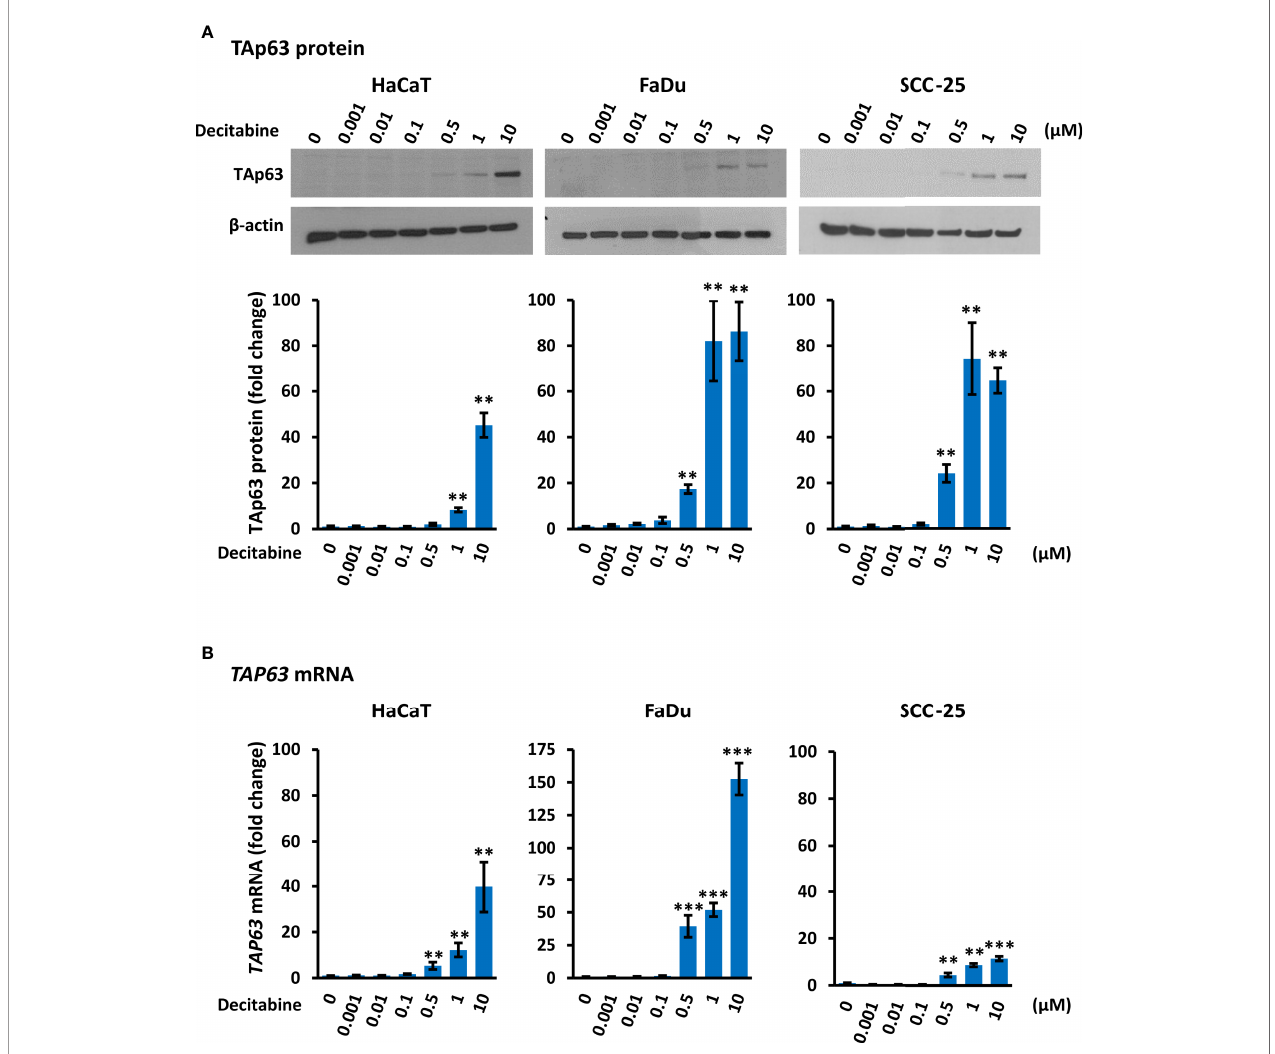
FIGURE 1 | Decitabine increases TAp63 protein and mRNA levels in squamous cells . (A) Representative Western blots of TAp63 in HaCaT, FaDu and SCC-25 cells cultured in the presence of the indicated concentration of decitabine for four days. b -actin is shown as loading control. Densitometry data normalized to b -actin are shown below, indicating fold change ± SEM compared to control cells (0, DMSO only; n = 3 for each dose in each cell line). (B) TAP63 mRNA levels normalized to ACTB mRNA (n = 3 to 5 biological replicates, each with technical triplicates). Data are shown as fold change ± SEM compared to control cells (0, DMSO only). Note the different y axis range for FaDu cells. **p < 0.01; ***p < 0.001 compared to